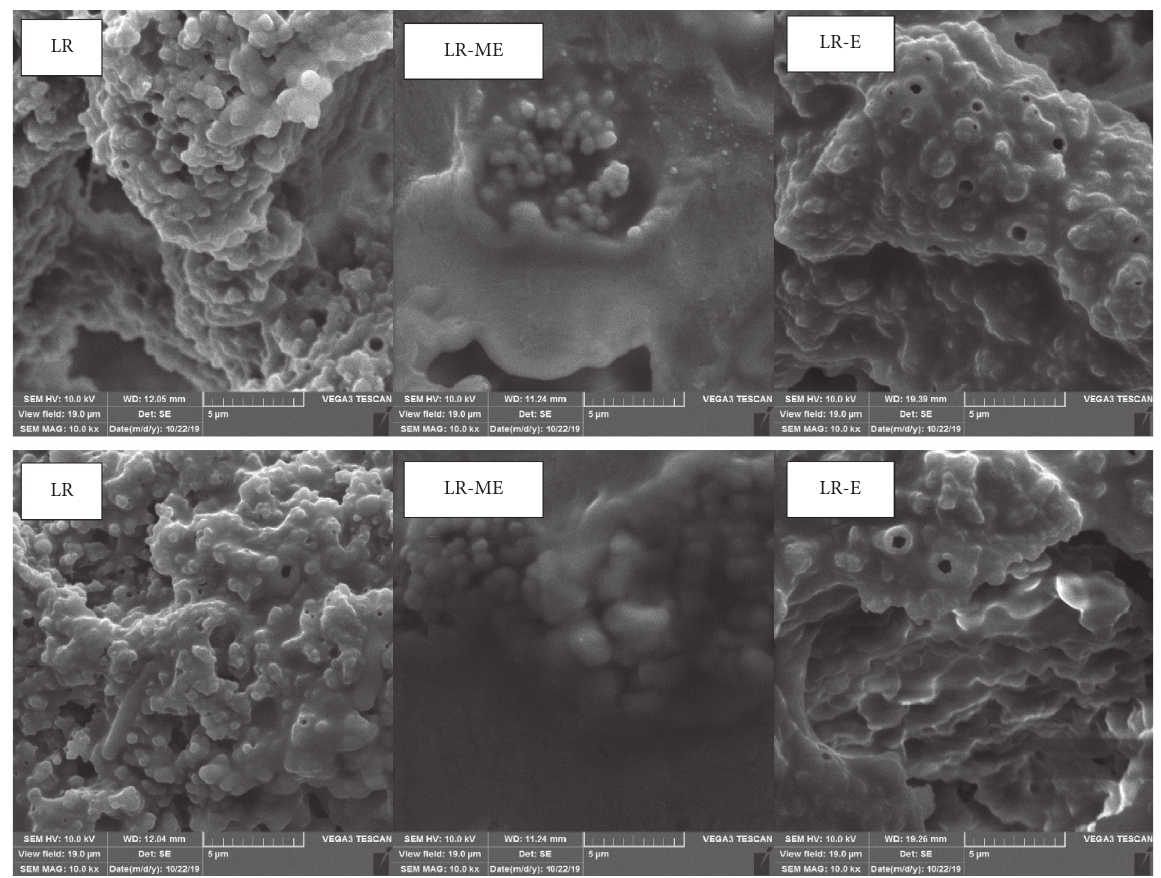
Figure 9: SEM micrograph parameters of probiotic yogurt. LR ( L. rhamnosus ), LR-ME (encapsulated L. rhamnosus in multilayer emulsion), LR-E (encapsulated L. rhamnosus in emulsion), LP ( L. plantarum ), LP-ME (encapsulated L. plantarum in multilayer emulsion), and LP-E (encapsulated L. plantarum in